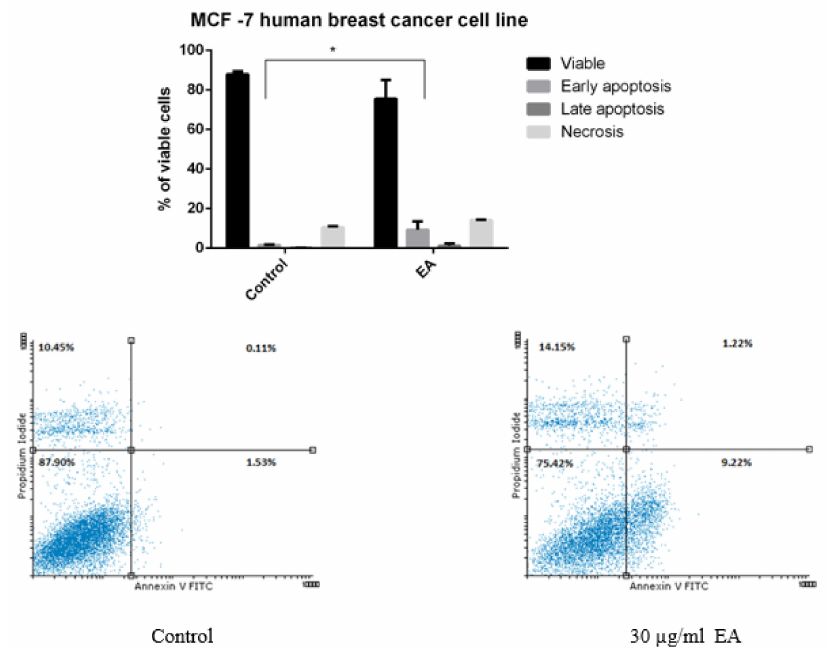
Figure 6. The evaluation of the pro-apoptotic activity of the MCF-7 human breast cancer cell line after 72 h of incubation with EA at the concentration of 30 µ g/mL (lower right quadrant: early apoptotic cells; upper right quadrant: late apoptotic cells; upper left quadrant: necrotic